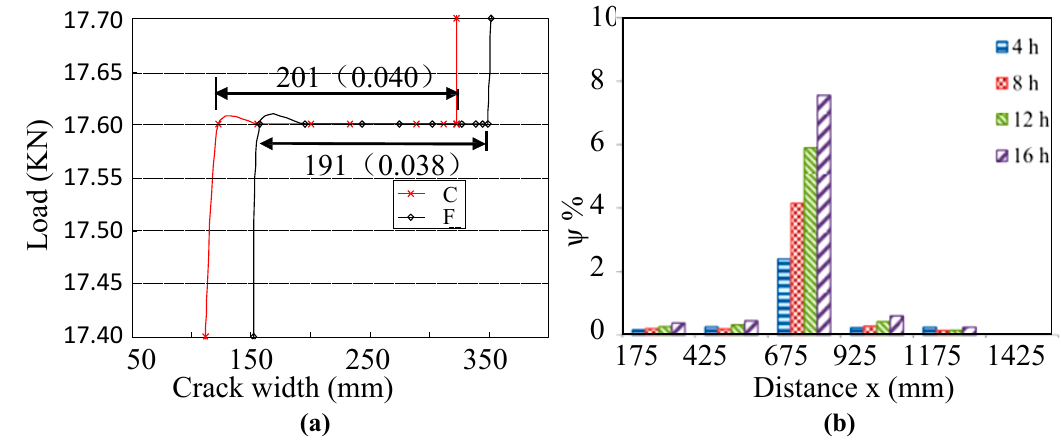
Figure 8. ( a ) A comparison of average crack width between long gauge FBG [37]; ( b ) Corrosion levels along the length of the beam based on CSR [67].